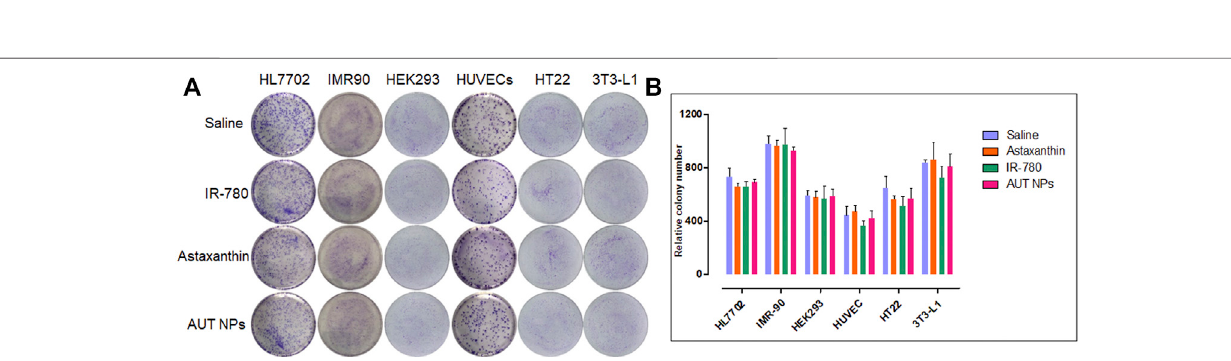
Frontiers in Chemistry |